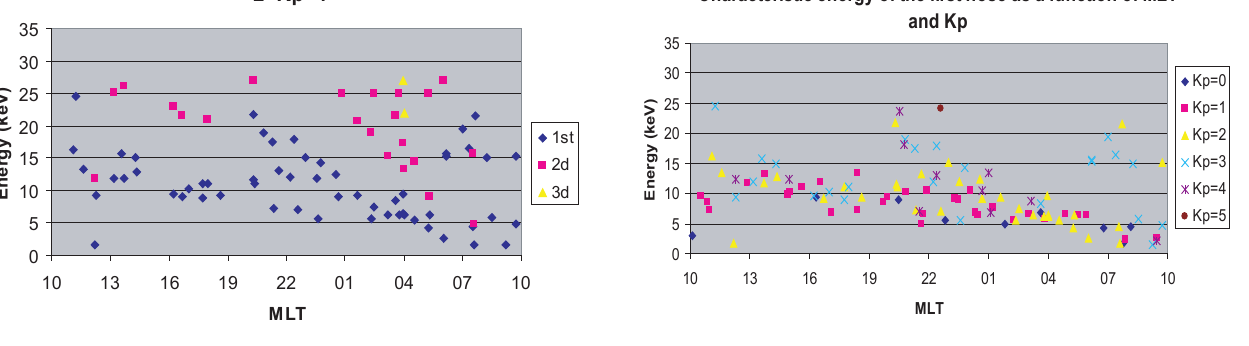
Fig. 8. Characteristic energy of each nose structure vs. MLT, for K p =2 and 3.